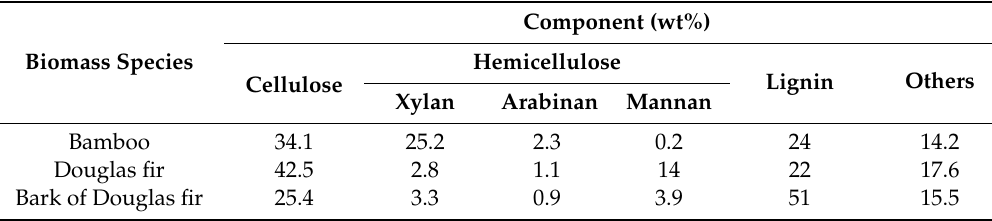
Table 1. Mass percentage of major components in the biomass